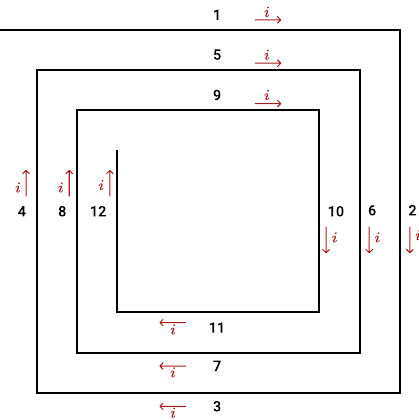
Figure 2. Square planar coil with three